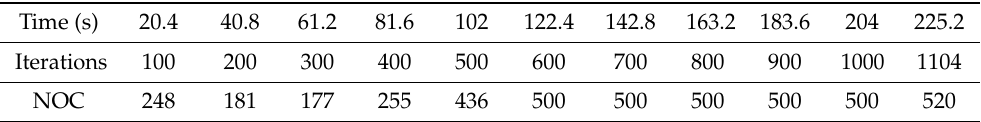
Table 6. Number of channels per 100 iterations (BET).